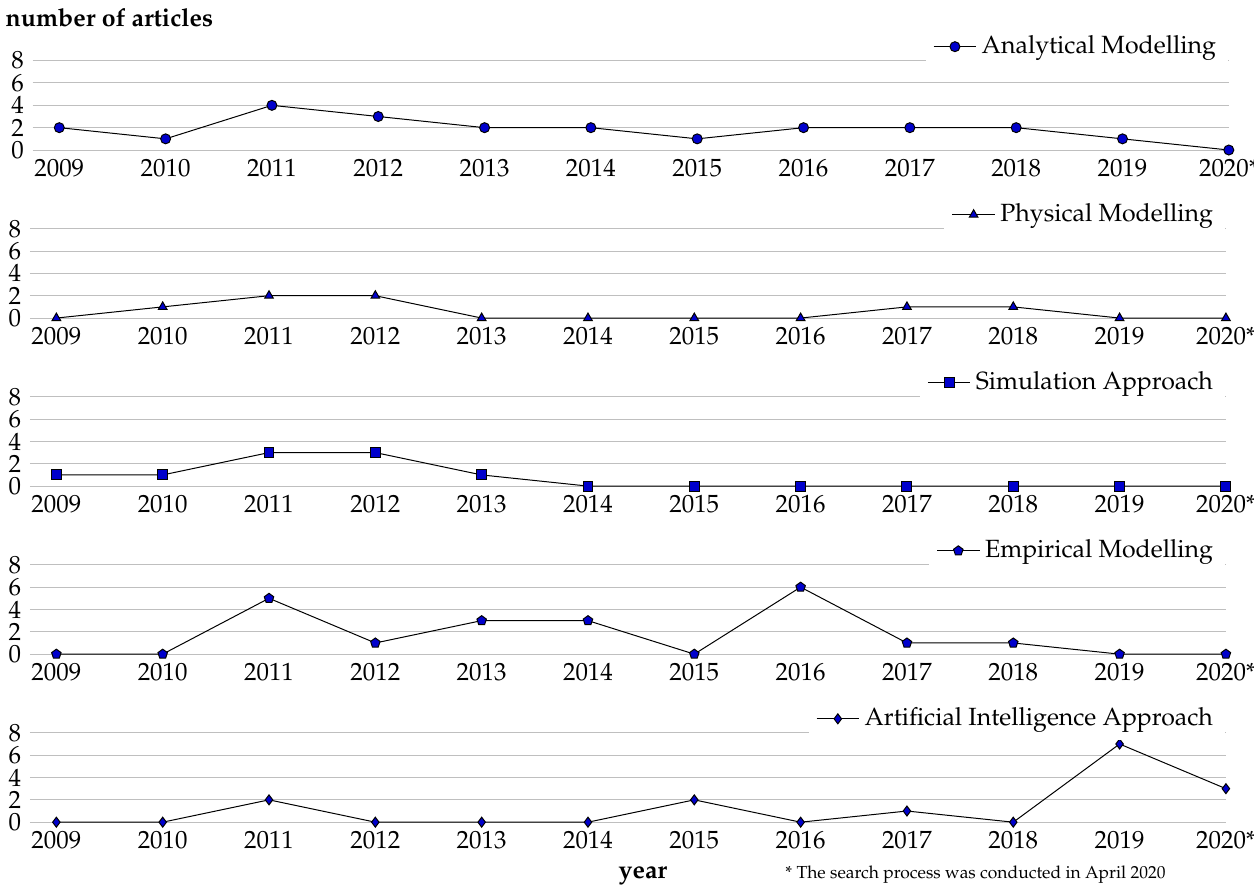
Figure 6. Number of articles over time for the category Modelling Technique.